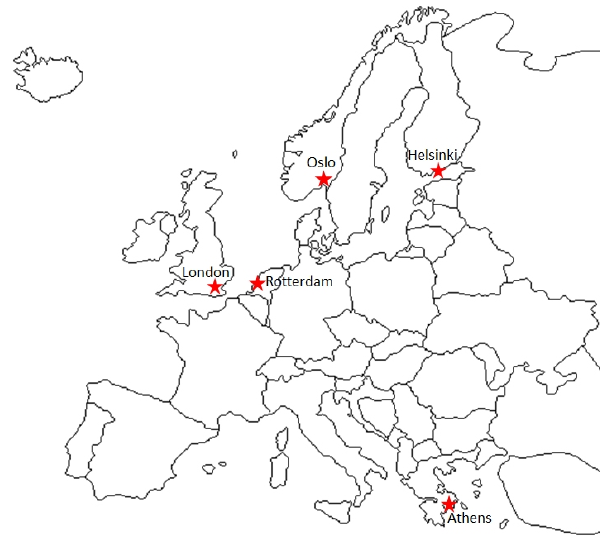
Figure 1. The target cities of this